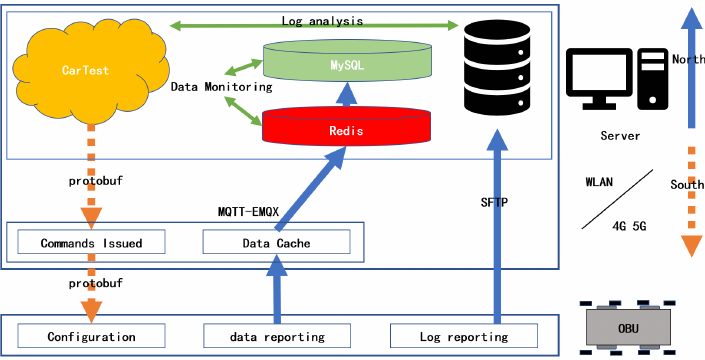
Figure 12. Indoor test data flow and software